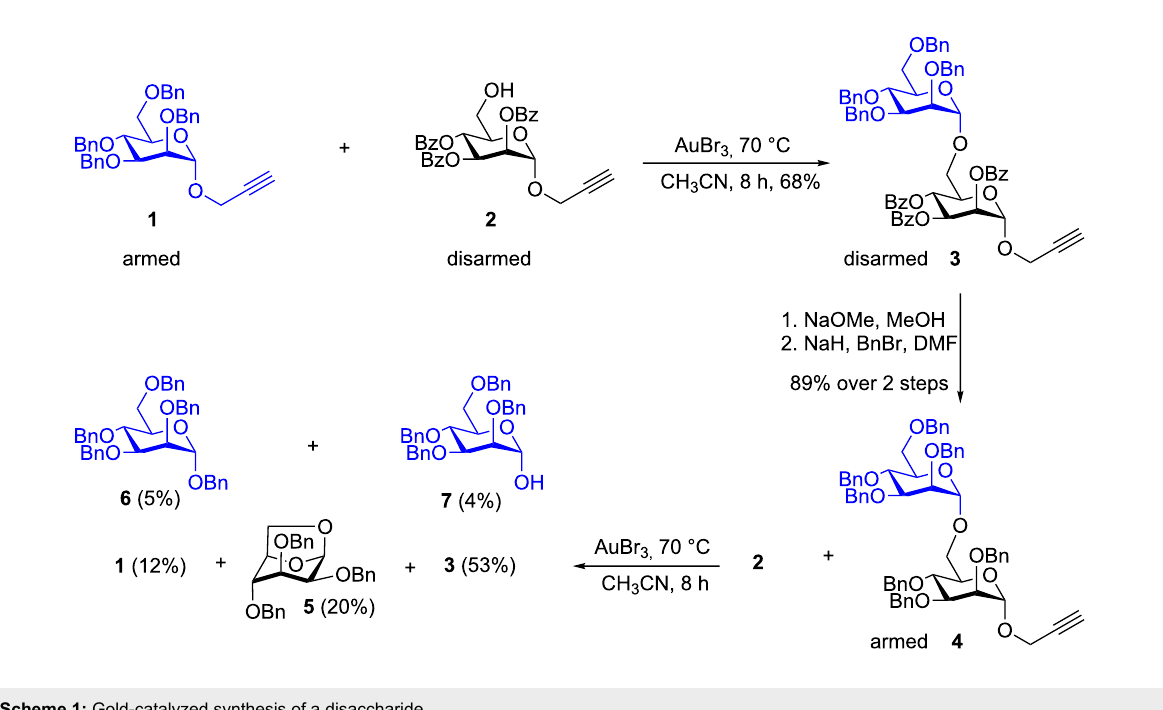
Scheme 1: Gold-catalyzed synthesis of a